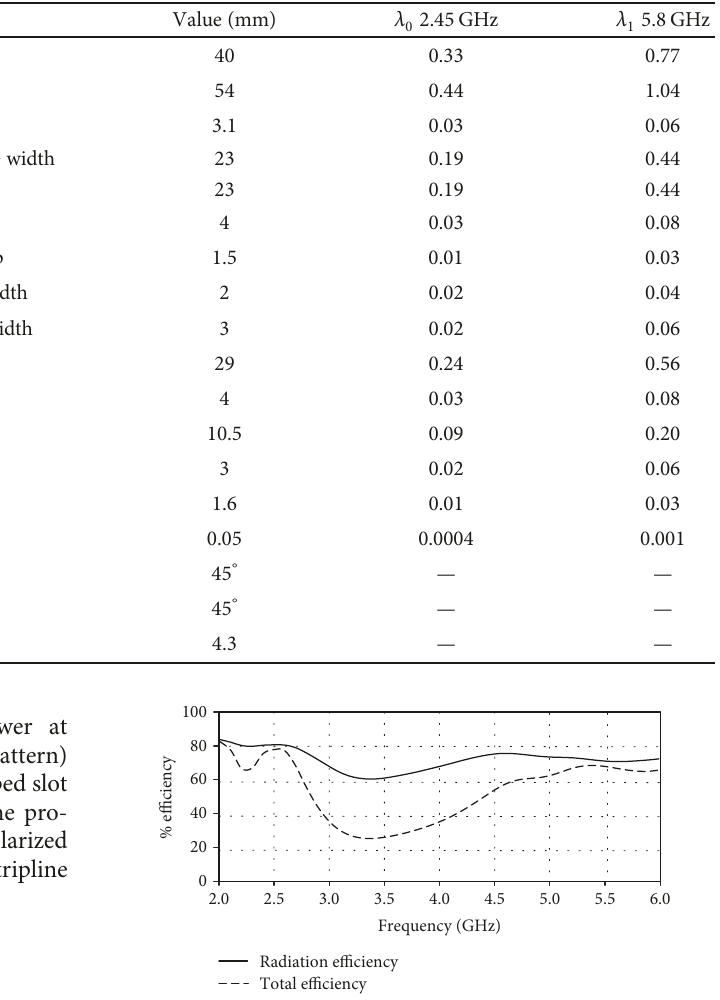
Figure 11: The simulated radiation and total e ffi ciencies of the proposed WLAN-enabled dual-frequency